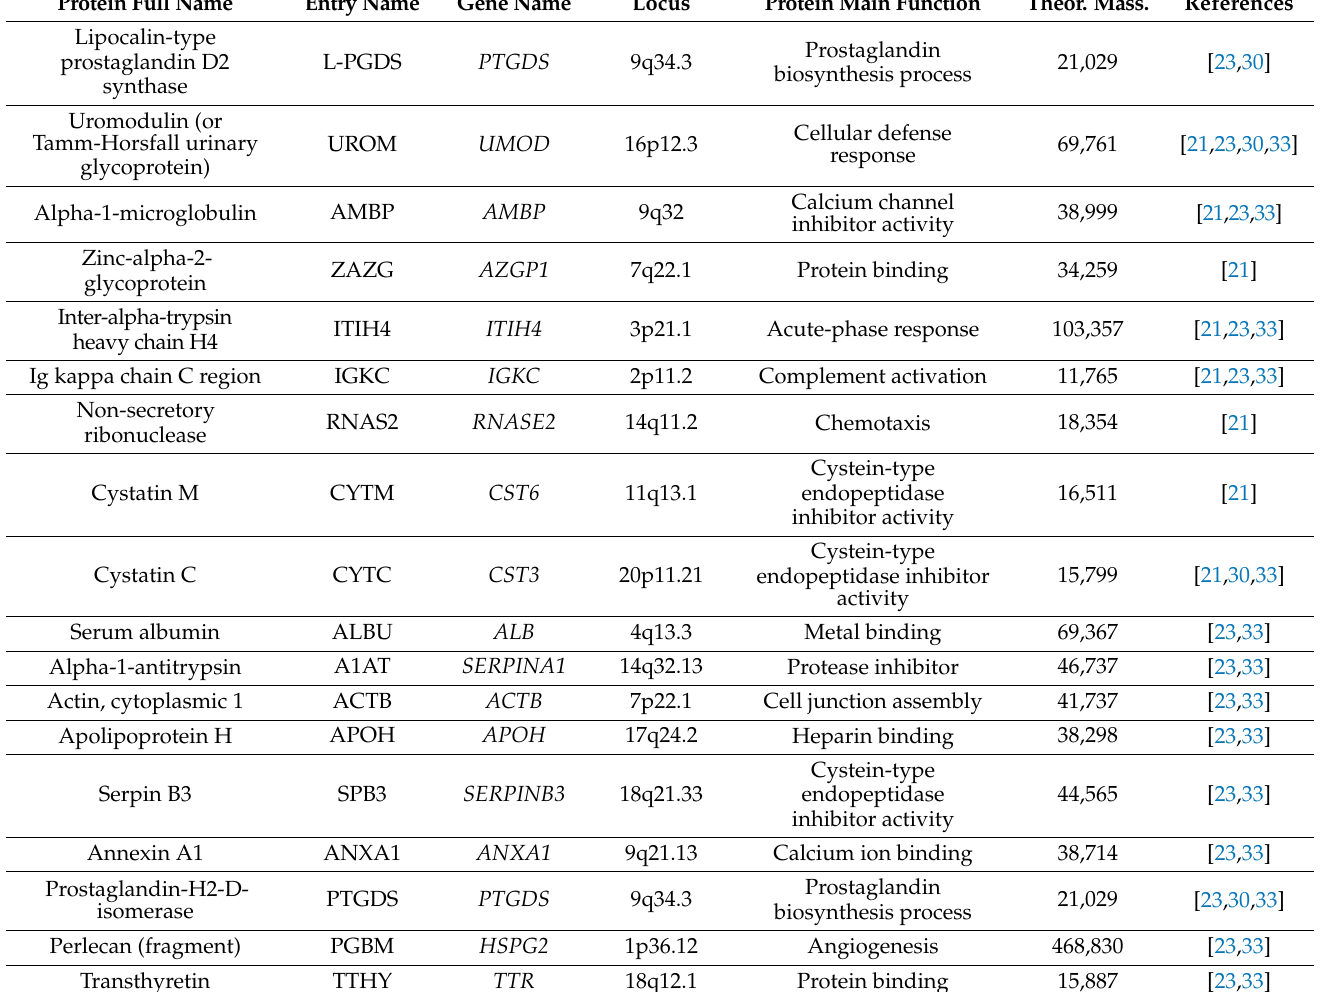
Table 2. Candidate urine proteomic biomarkers of medication-overuse